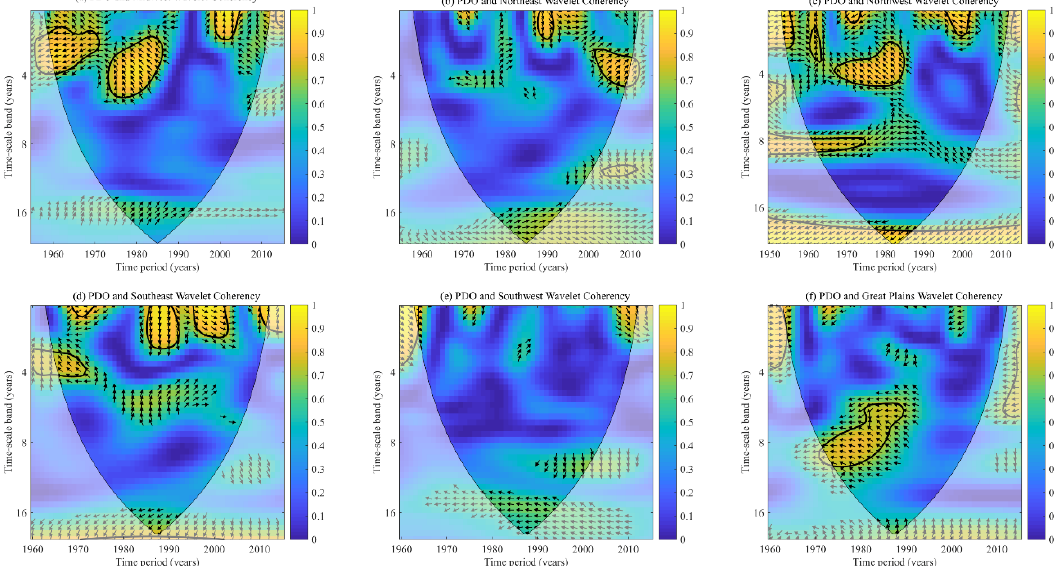
Figure 11. Wavelet coherency (WTC) spectrums between PDO and the regional streamflow of ( a ) Midwest; ( b ) Northeast; ( c ) Northwest; ( d ) Southeast; ( e ) Southwest; and ( f ) Great Plains. Warmer (yellow) color represents a higher correlation between the two time series. The arrows indicate the relative phase relationship within the significant zones of higher correlation.